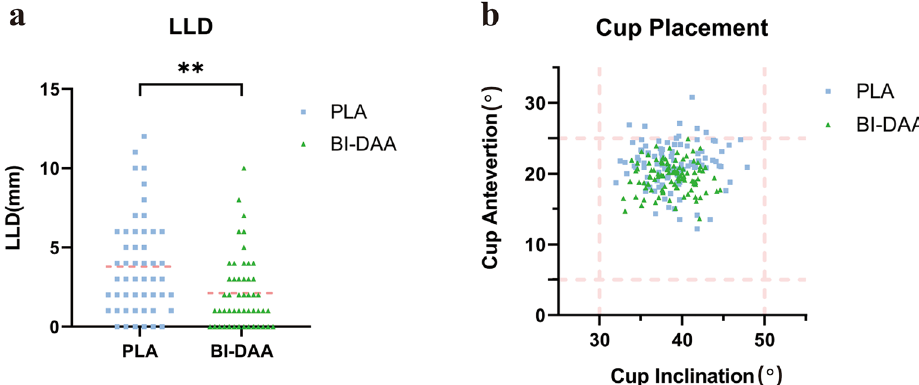
Figure 3. Prosthesis position evaluation. ( a ) The LLD value for each patient in the BI-DAA (green triangles) group and PLA group (blue squares), means of LLD in each group are noted as pink dot lines, ** P < 0.01. ( b ) The scatter plot shows the acetabular inclination angles and anteversion angles of the BI-DAA group (green triangles) and PLA group (blue squares). The pink dot lines indicate the boundaries of the safe zones. BI-DAA,